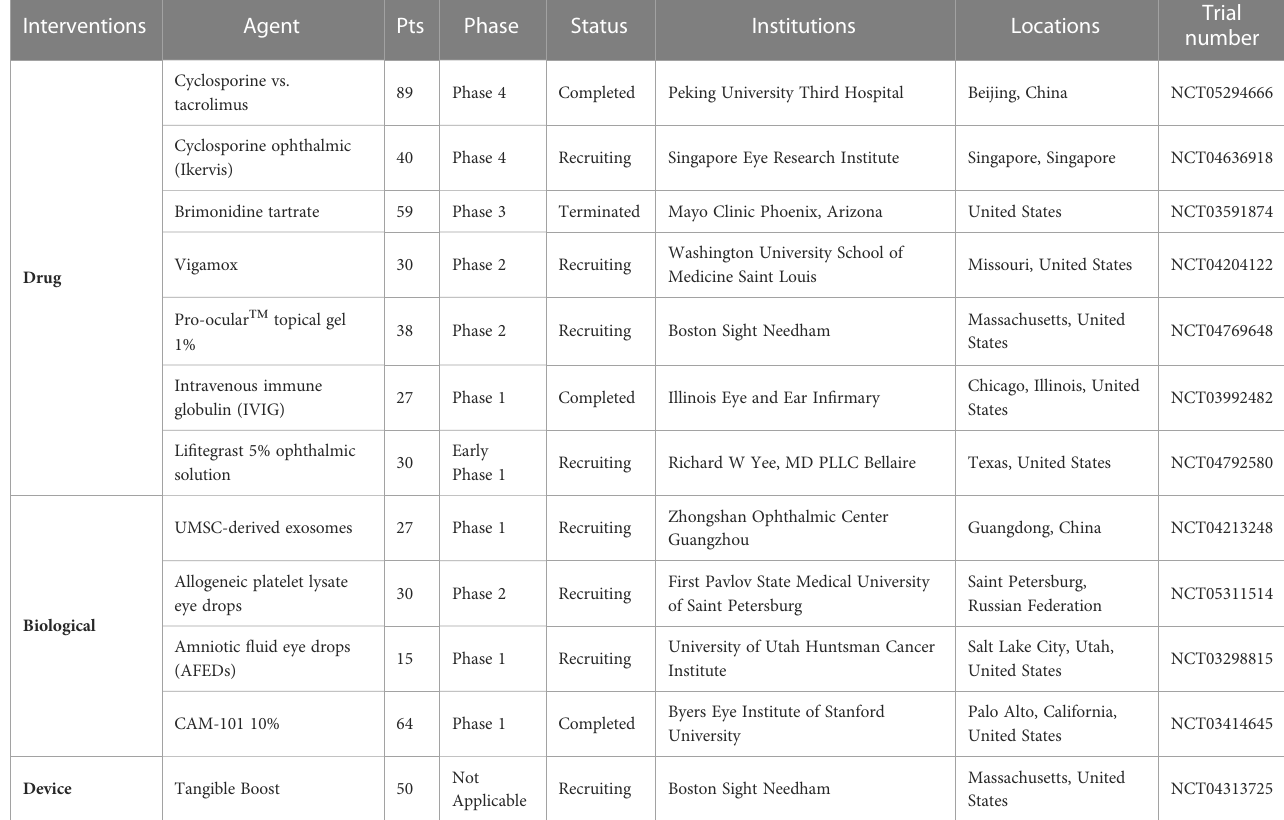
TABLE 1 Registered clinical trials of ocular GVHD (from January 2018 to September 2022).